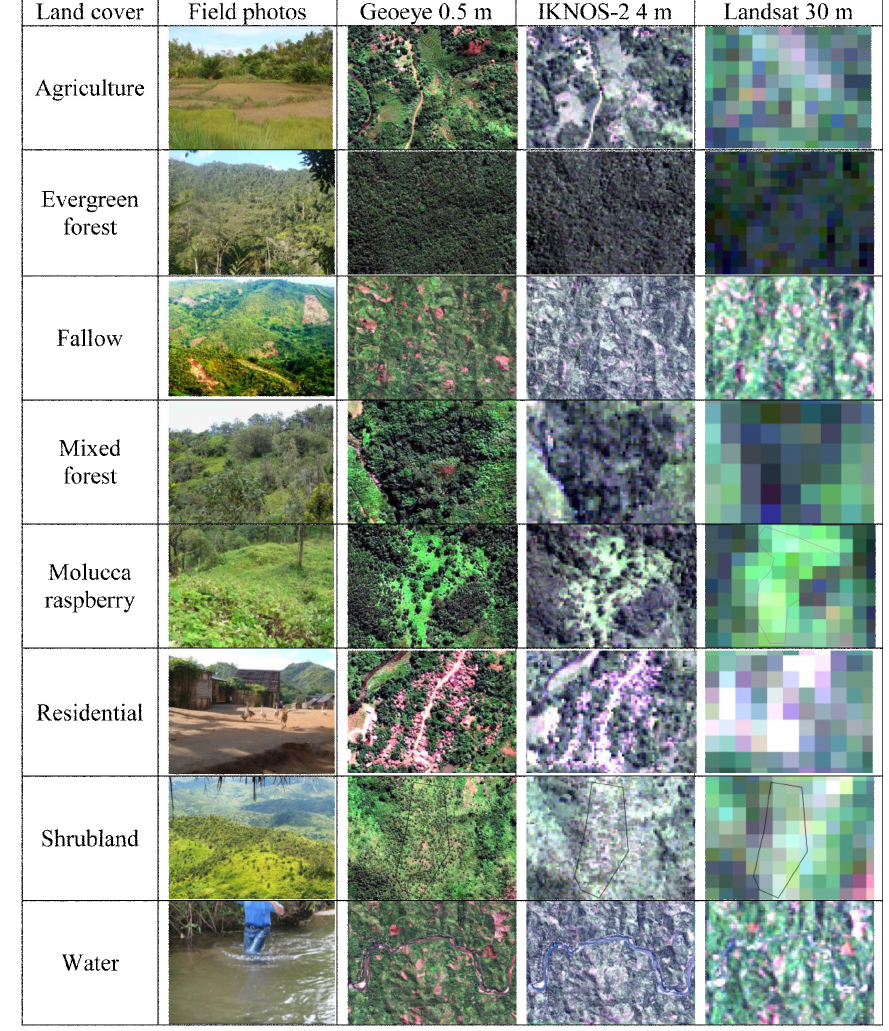
Figure 3. Major land cover types at different spatial